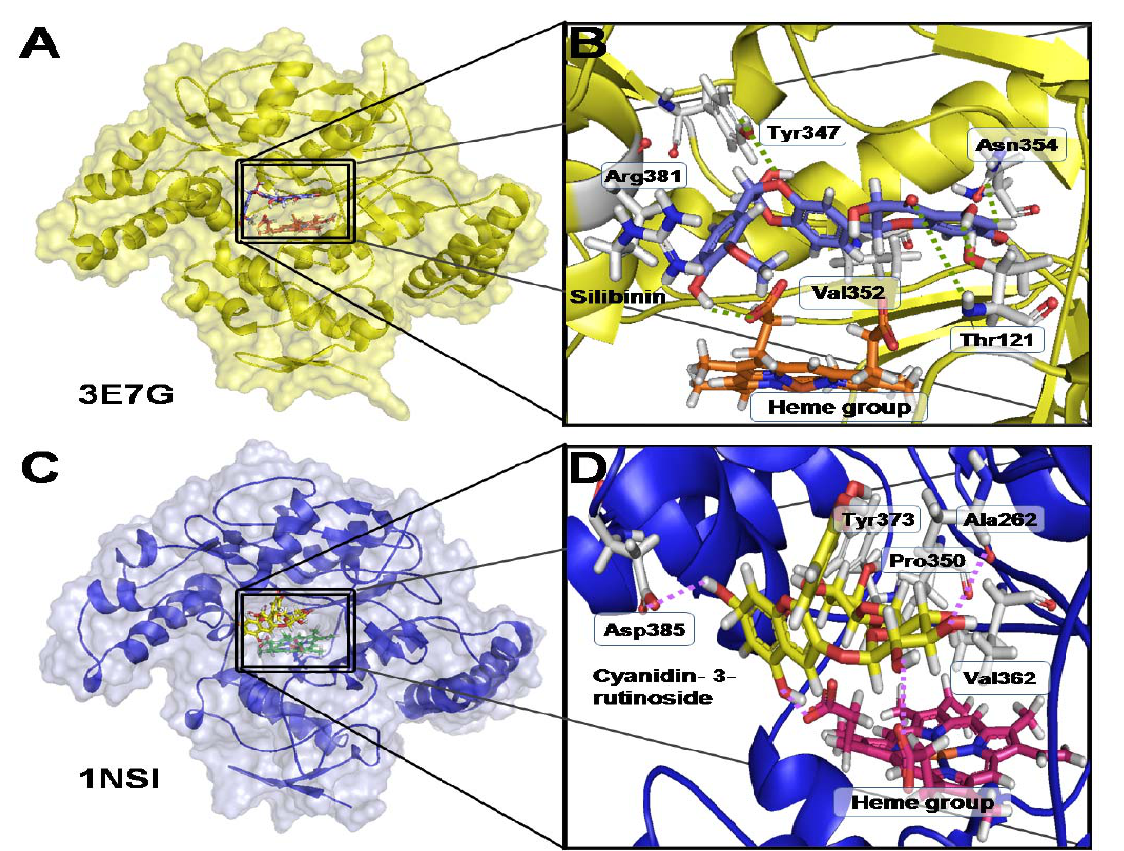
Figure 1. 3D view and interacting residues present in the 3E7G/silibinin ( A , B ) and 1NSI/cyanidin-3-rutinoside ( C , D )